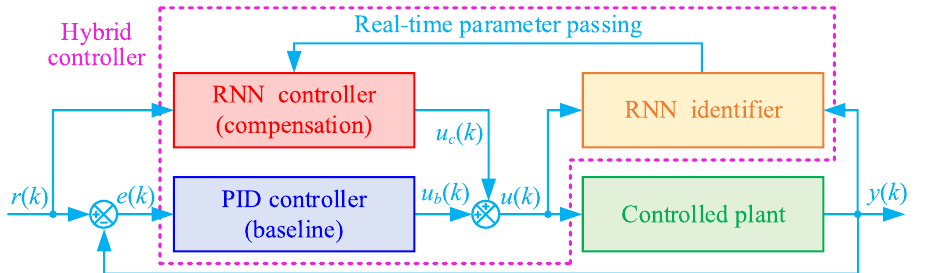
Figure 2. Structure diagram of the hybrid control strategy based on